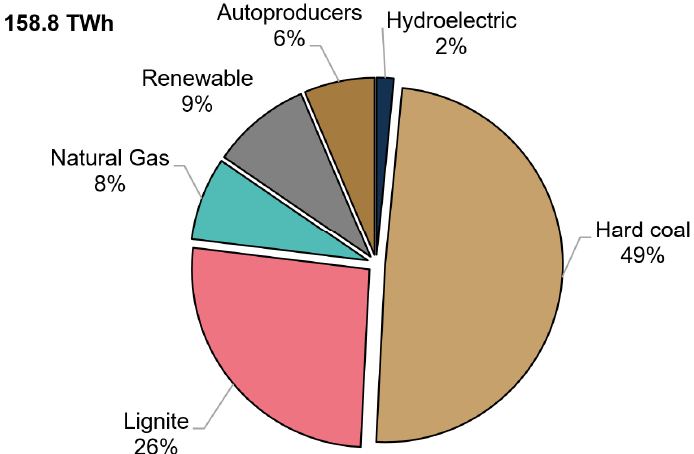
Figure 1. Electricity production in Poland in 2019.